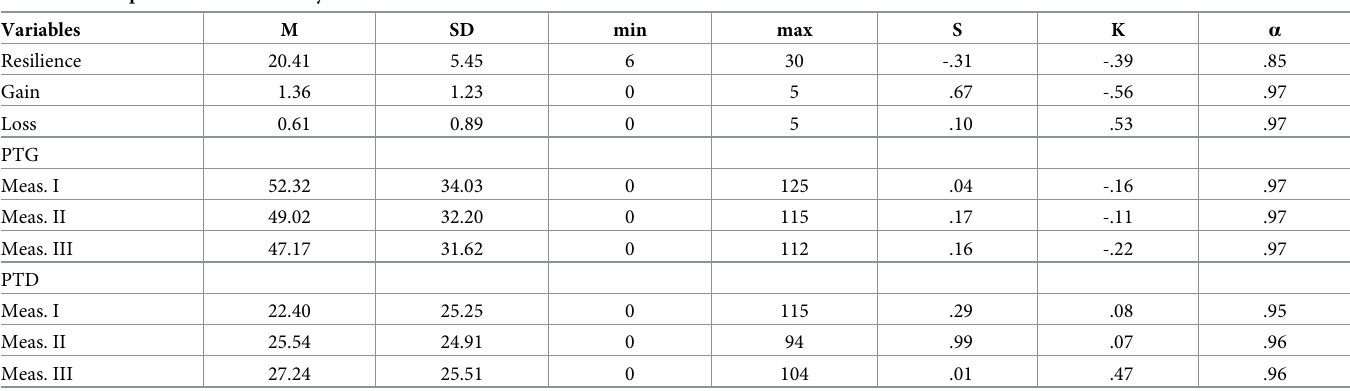
Table 2. Descriptive statistics for analyzed